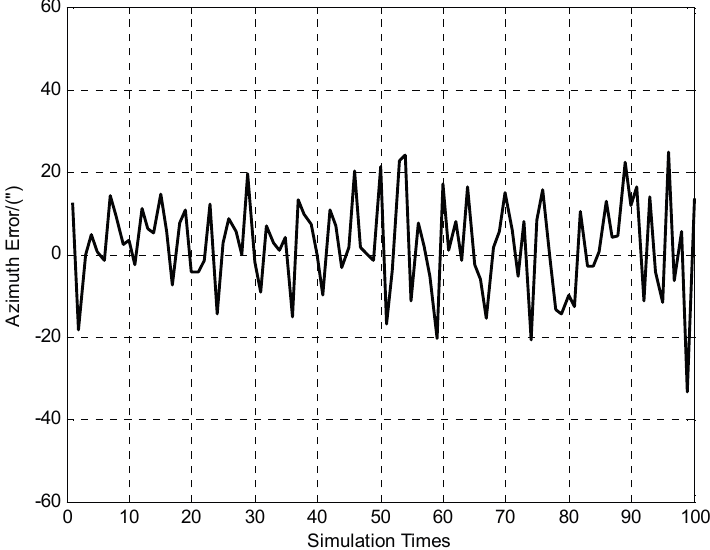
Figure 6. 100 times of azimuth error determination